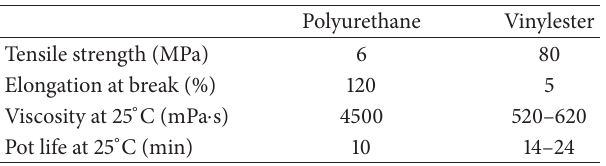
Table 1: Properties of